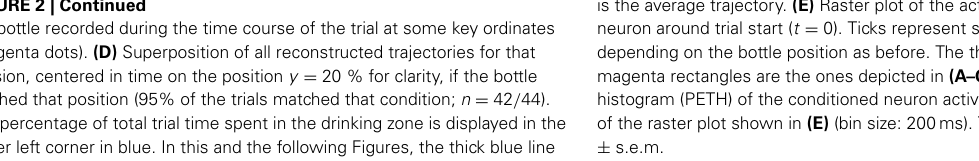
the graph for Trial and Waiting (gray dots and error bars). The star indicates a significant difference (paired sample Wilcoxon test, P < 5 . 10 − 16 ). (C1) Same as (A) , but the activity used for trajectory reconstruction was the trial activity, shuffled by blocks of two seconds (93% of trials plotted). (C2) Distribution of the drinking time percentage obtained in (C1) , with a bootstrap analysis of 10,000 shuffles. The value found with real trial activity is indicated by the vertical magenta arrow and corresponds to a z-score of 9.2. (D) Distribution of the z-scores of the real time spent in the drinking zone compared to the bootstrap distribution for shuffled activity, for all the sessions. Magenta, histogram for the seven best sessions (one per neuron). Dashed lines, z-score = − 2 and 2; full line, z-score = 0. The gray dot and error bar indicate the mean ±